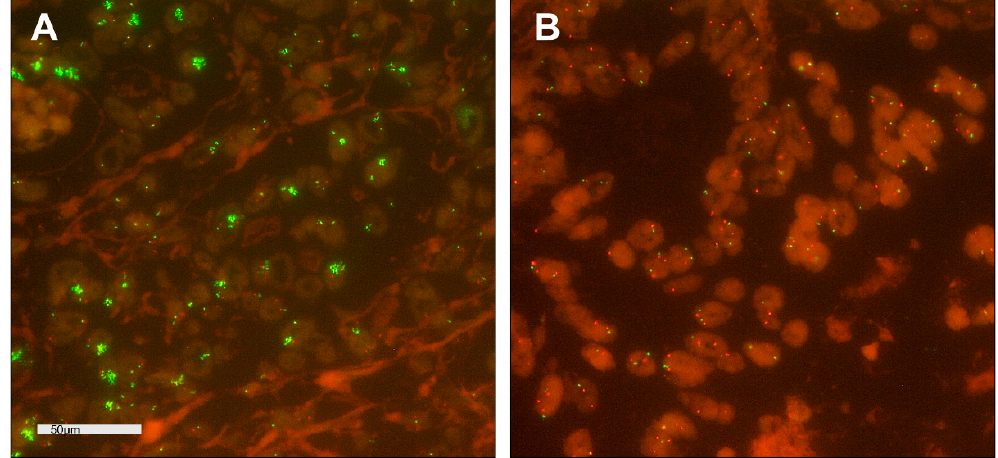
Figure 3. Fluorescence in ‐ situ hybridization (FISH) analysis of GATA6 in arrayed esophageal adenocarcinomas; magnification x630; Copy Number Variations; GATA6 ≙ green; CEN18 ≙ orange; ( A ) tumor cells with cluster amplification of green GATA6 signals; ( B ) tumor cells with normal distribution of GATA6 and CEN18 signals.